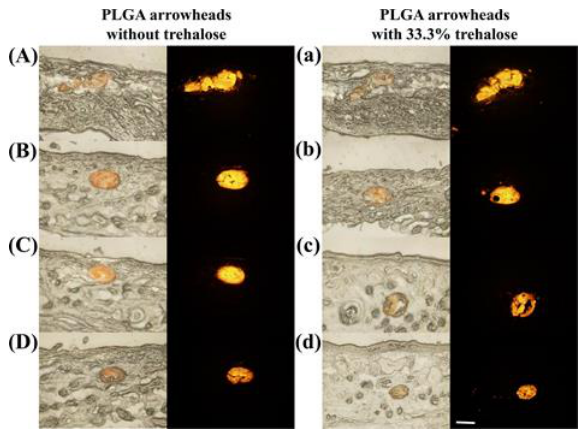
Figure 9. In vivo degradation of FR-loaded PLGA arrowheads without trehalose and with 33.3% trehalose. Histological sections of rat skin at day 0 ( A , a ), 1 week ( B , b ), 2 weeks ( C , c ), and 3 weeks ( D , d ) after application of FR-loaded IPMNs in vivo. For each group, the left image shows bright-field micrographs, and the right image shows fluorescence images. Scale bar, 100 μm.